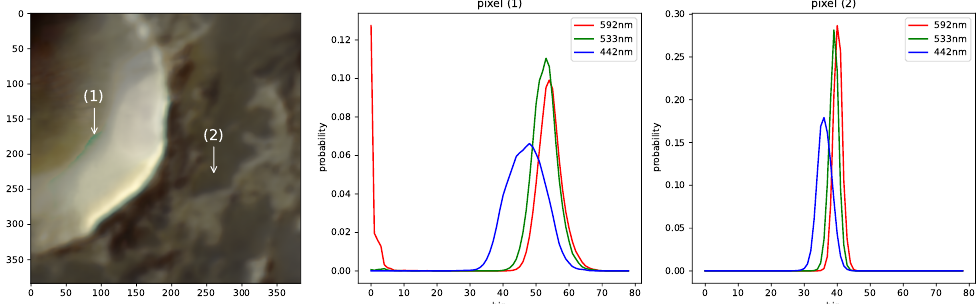
Figure 16. Two marked pixels from a predicted EVC patch ( left ) and their associated bin probabilities across three bands from a faulty region ( center ) and a regular region ( right